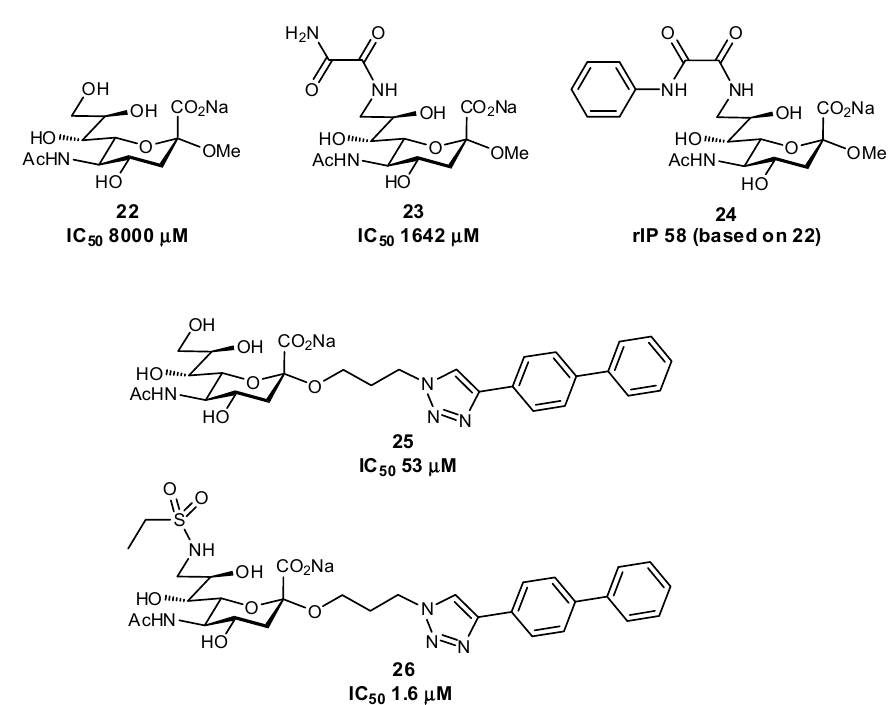
Figure 8. Inhibitors of Siglec-7 which target additional protein interactions through modification at C-2 and C-9 positions (rIP = relative inhibitory potency) [67,68].